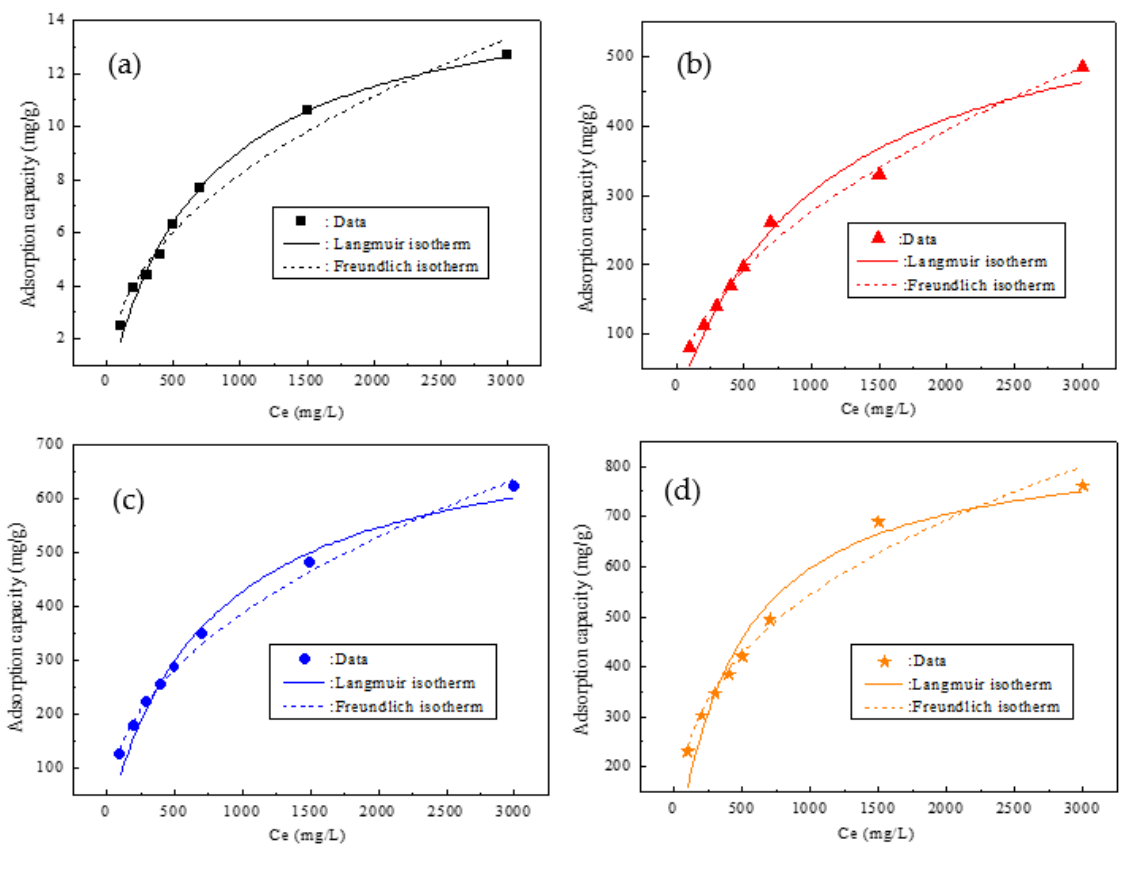
Figure 6. Adsorption isotherms with different concentrations of Pb 2+ in raw steel slag and the nanocomposite samples prepared with different additions of MDP: ( a ) raw steel slag (S0), ( b ) S1 (0 g MDP), ( c ) S2 (10 g MDP), and ( d ) S3 (30 g MDP). Table 1. Fitting parameters for the adsorption isotherms of Pb 2+ for different concentrations of raw steel slag and the nanocomposite samples prepared with different additions of MDP. Langmuir Sample